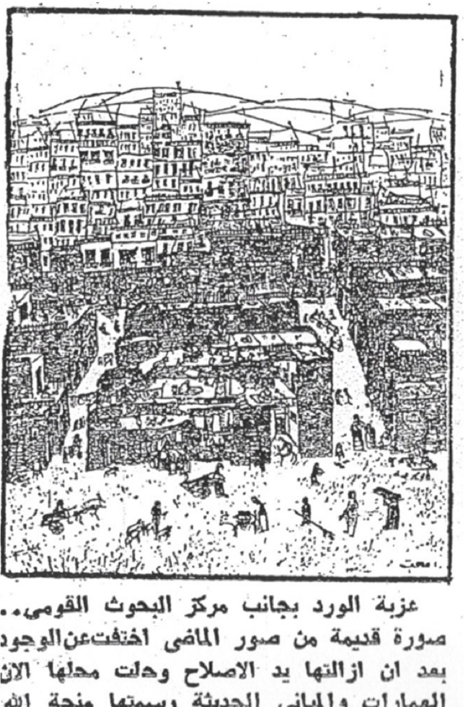
Figure 15. Caption from 1966 newspaper showing the etching by Menhat Helmy, entitled Ezbet al-Ward (1965).